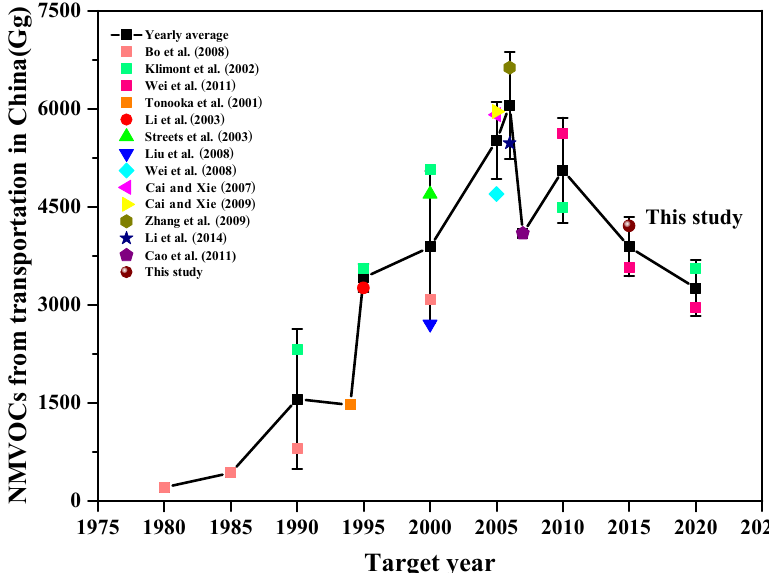
Figure 8. Comparison of this study to previous transportation emission